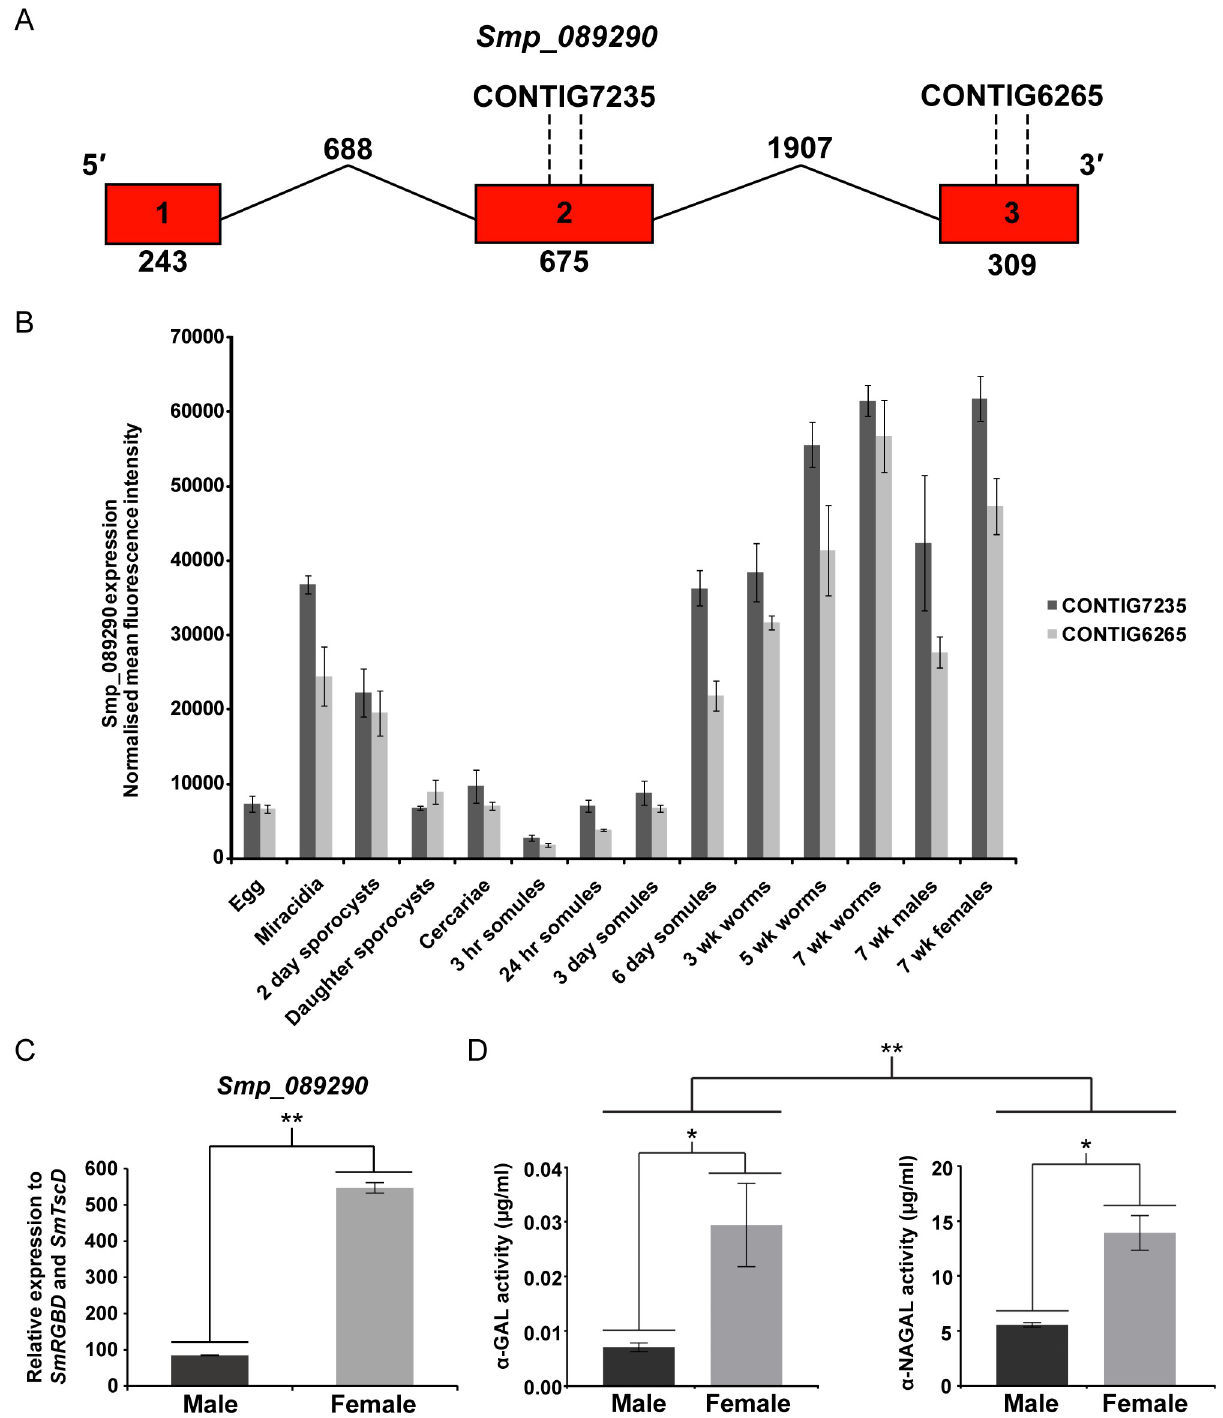
Fig 4. smnagal ( smp_089290 ) expression and α -NAGAL/ α -GAL activities are female-enriched. (A) Diagrammatic representation of smnagal / smp_089290 gene structure with 50-mer oligonucleotides mapped. Exons are depicted as red boxes, which are linked by lines representing introns. Numbers written inside each exon represent their position in the gene sequence. Numbers written below exons and above introns represent their length in base pairs. The 5 0 and 3 0 ends are shown above exon 1 and 3, respectively. The positions of oligonucleotide 50-mers corresponding to CONTIG7235 and CONTIG6265 are shown above exon 2 and 3 respectively. (B) DNA microarray analysis of smp_089290 expression across 15 lifecycle stages. DNA microarray gene expression profile consisted of normalised mean fluorescence intensities of smnagal / smp_089290 transcript abundance derived from oligonucleotides CONTIG7235 and CONTIG6265 as described previously [45]. (C) smnagal / smp_089290 transcript levels in untreated adult male and female were quantified relative to smrgbd and smtscd to validate normalised mean fluorescence intensities produced in 7 wk male and 7 wk female schistosomes. Statistical significance is indicated (Student’s t -test, two tailed, unequal variance, �� = p < 0.01). (D) Equal quantities of SWAP (5 μ g per